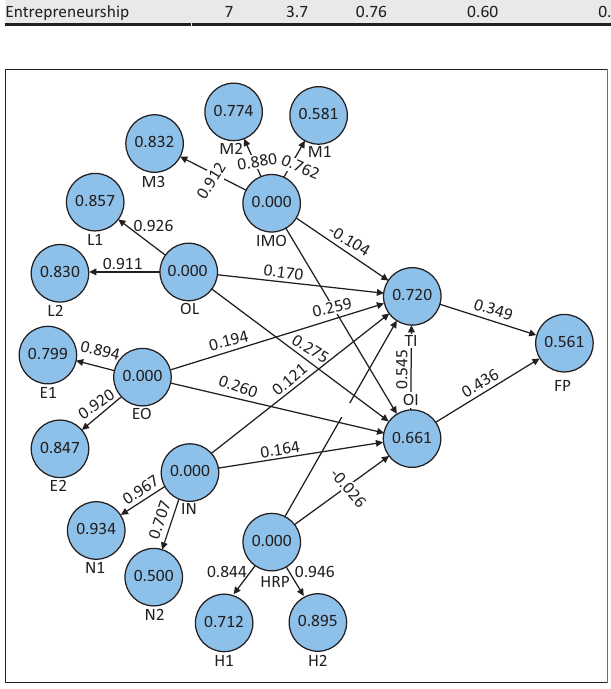
Marketing innovation